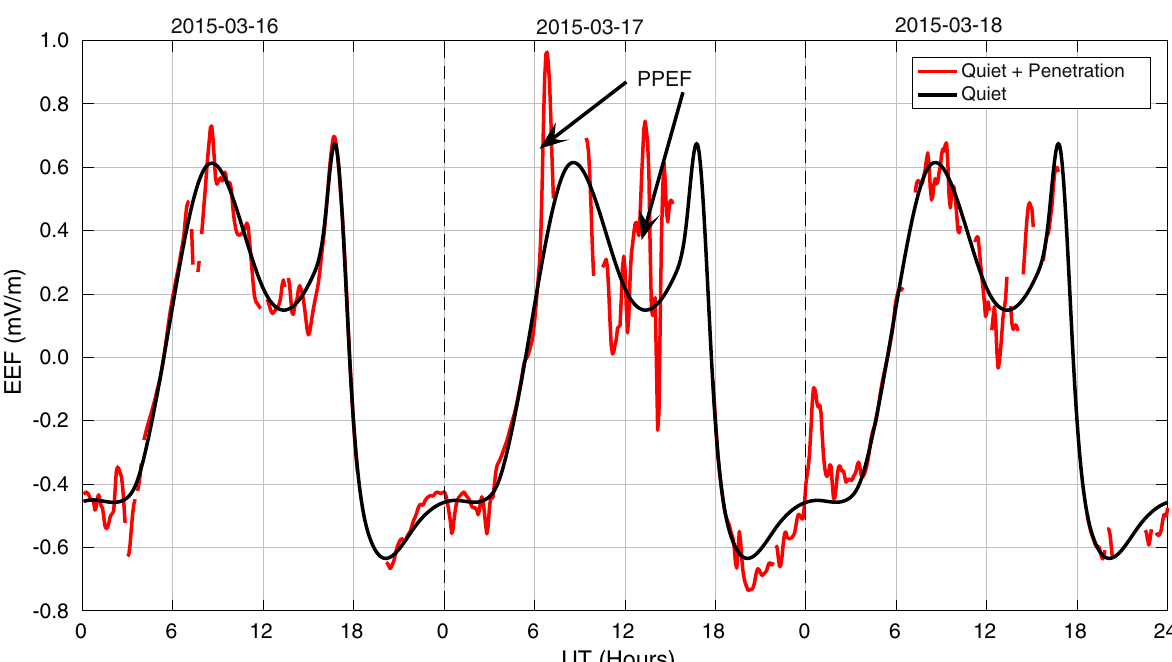
Fig. 6 Same as Fig. 5 but for the geomagnetic storm of 16–18 March